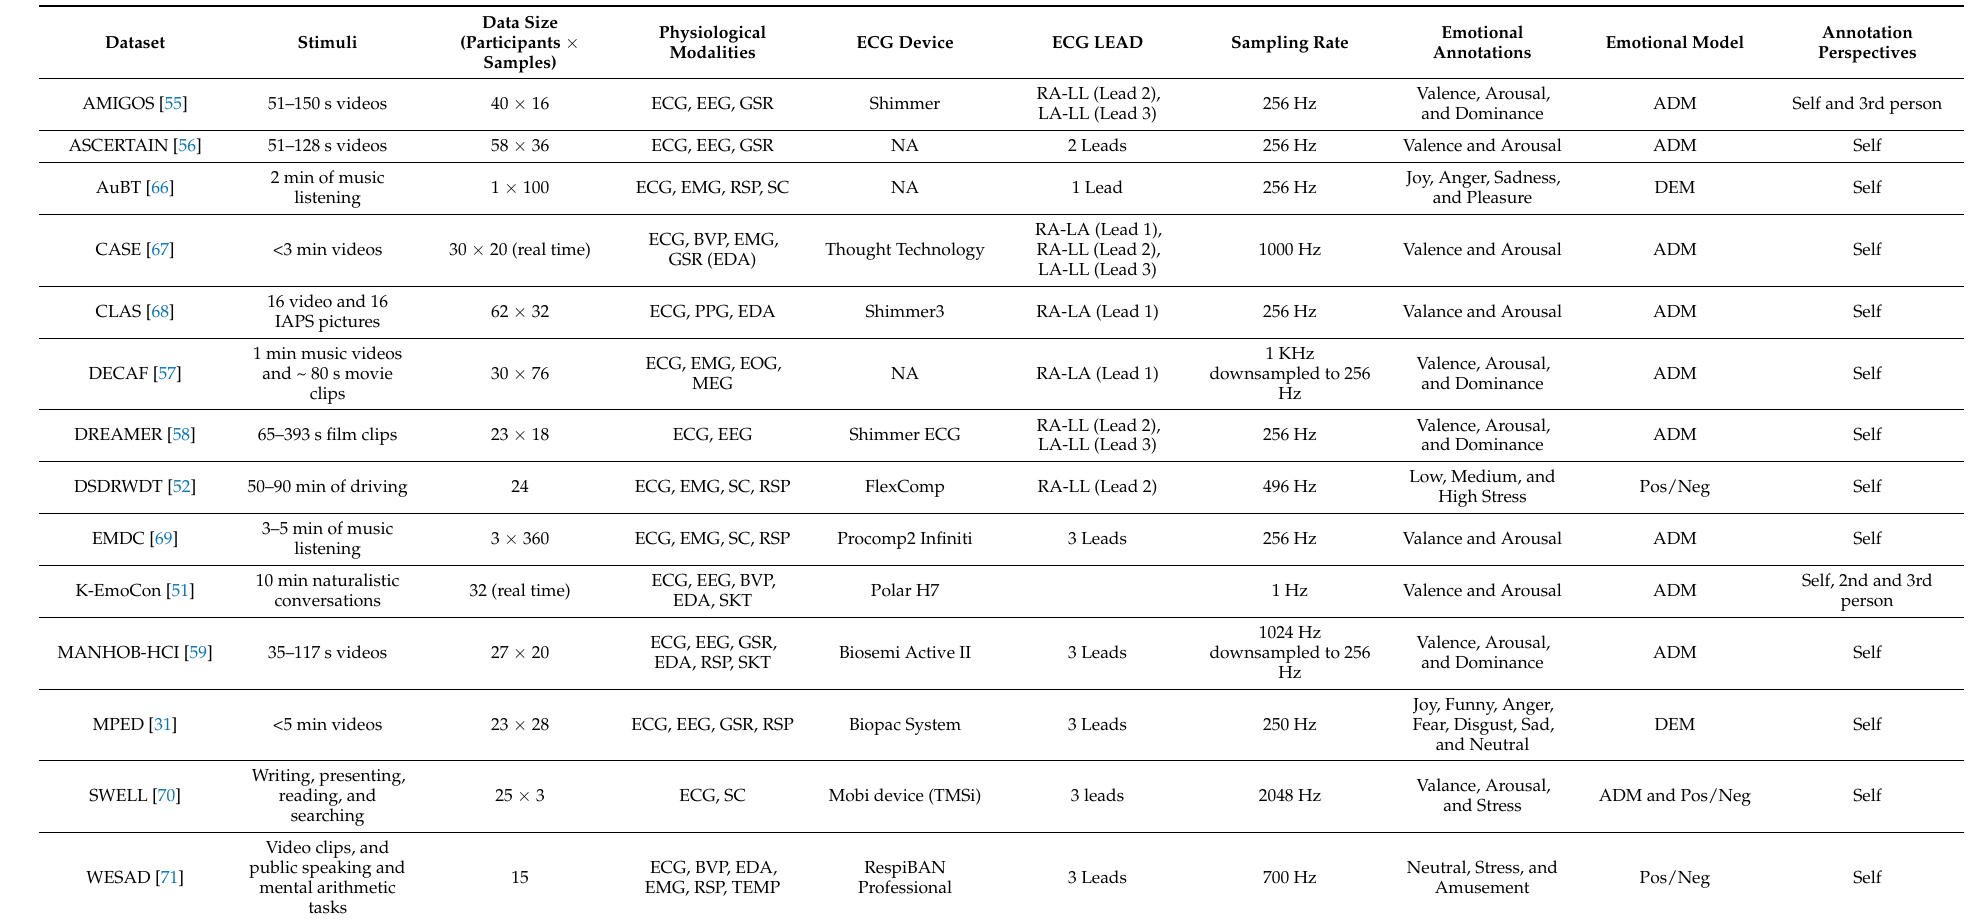
Table 2. Affective datasets available with the inclusion of the ECG